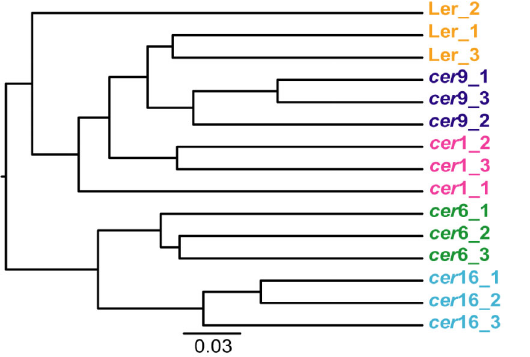
Figure 4. OTU level resolution of plant line resident bacterial communities. A heatmap of the resident community OTUs of the five plant lines under investigation (present=dark blue, absent=light blue) is shown. The closest possible taxonomic affiliation is given. Grey writing indicates that these taxa were identified as chimeras in either the Greengenes or the Silva_r108 reference dataset but not in both. The six ubiquitously present OTUs are highlighted in dark red and the OTUs that are present in 14/15 samples are marked in light red (‘‘core’’ community). All taxa that were found in at least one plant line and were absent from at least one other plant line are highlighted in yellow (‘‘plant line-specific’’ community). OTUs marked with ‘‘ + ’’ also contained highest sequence counts (Tab.S3).